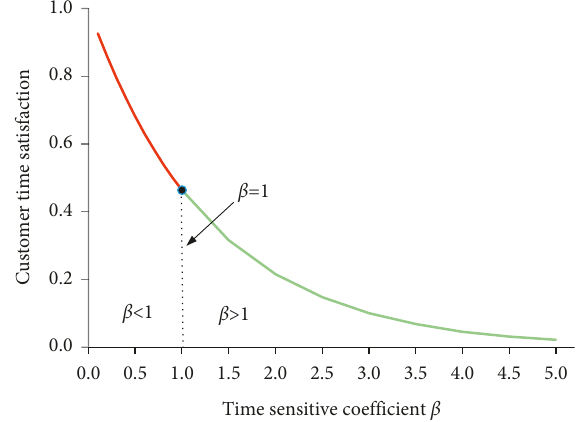
Figure 11: Impact of time sensitivity coefficient on customer time